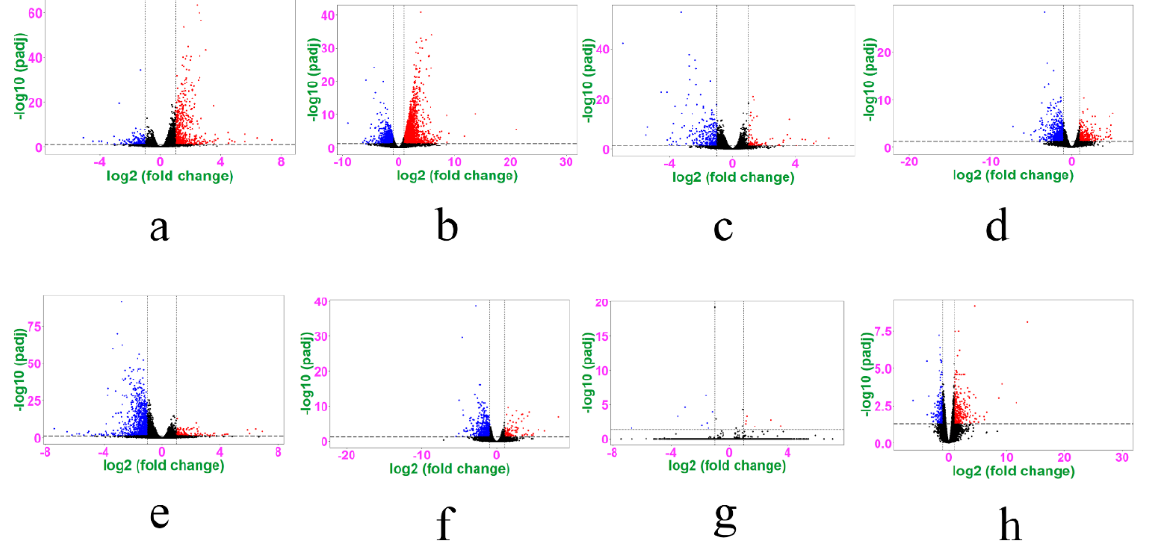
Figure 2. Volcano plot of eight groups of DEGs (hypothalamus and ovary from FM_1-vs-NM_1, FM_2-vs-NM_2, FM_1-vs- FM_2, and NM_1-vs- NM_2 groups). The hypothalamus ( a ) and ovary ( b ) in the FM_1 -vs- NM_1, hypothalamus ( c ), and ovary ( d ) in the FM_2 -vs- NM_2; hypothalamus